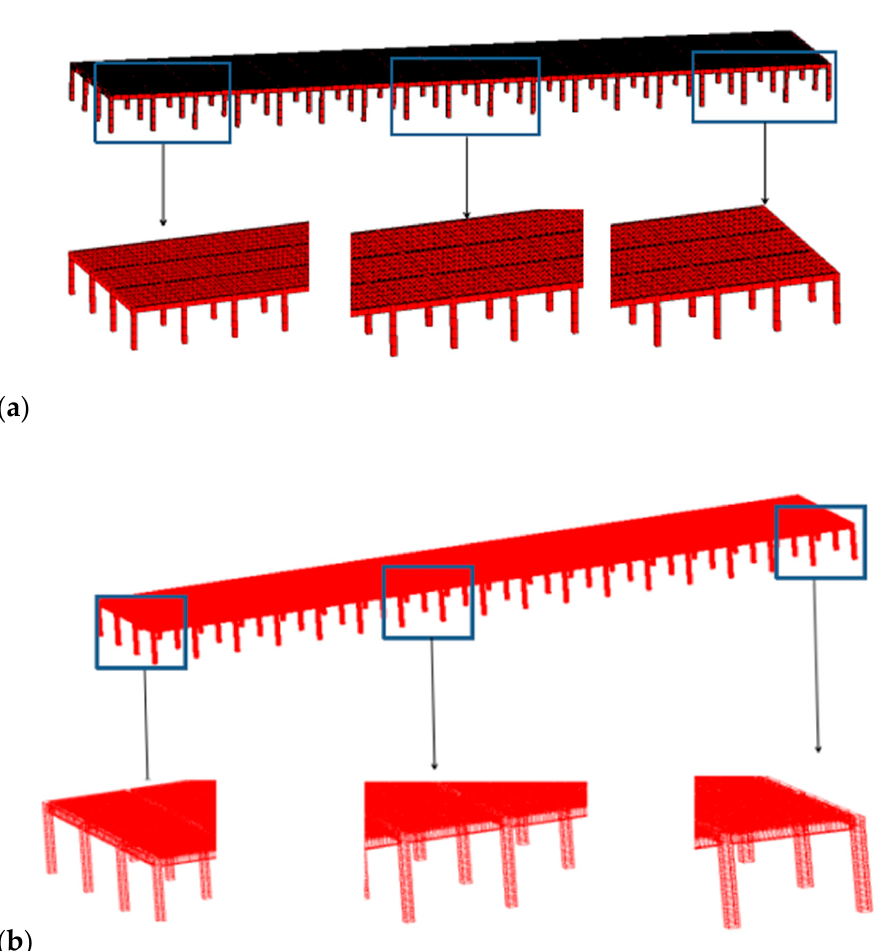
Figure 3. Vertical view of the finite element model: ( a ) Mesh model; ( b ) Reinforcing bars model. Setting post-cast strips during the construction process is one of the important means of mitigating the adverse effects caused by temperature action. To simulate the construction process, differences in the construction process were reflected by the quantity and the indwelling time of post-cast strips, and the temperature loads were applied in stages according to the setting of the post-cast strips. Since the tensile strength of the concrete is significantly lower than the compressive strength, the temperature stresses caused by the cooling action are the main indicators in the analysis of the effect of the structure. To analyze the plastic development process of the concrete cracking, the following incremental schemes were adopted: the model was uniformly cooled as a whole and loaded from − 1 to − 30 ◦ C, while the structure was only subjected to the cooling effect without the self-weight